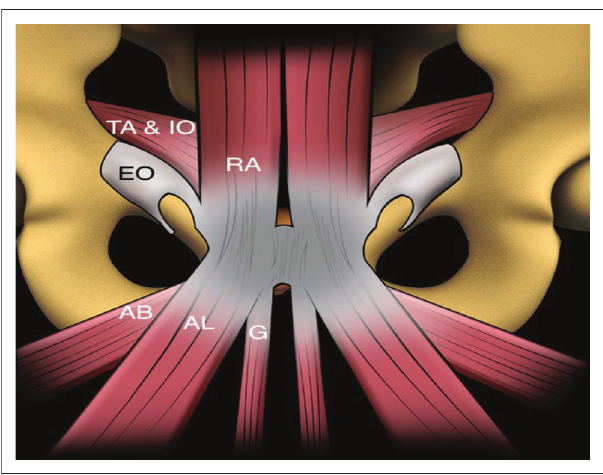
FIGURE 1: Musculotendinous and aponeurotic attachments of the anterior pubis. AB, adductor brevis; AL, adductor longus; EO, external oblique aponeurosis; G, gracilis; IO, internal oblique; RA, rectus abdominis; TA, transversus abdominis.